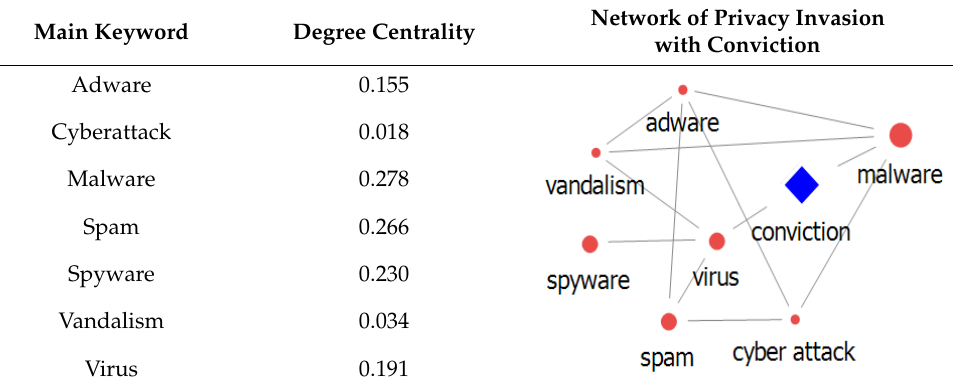
Table 5. Degree Centrality of Conviction.